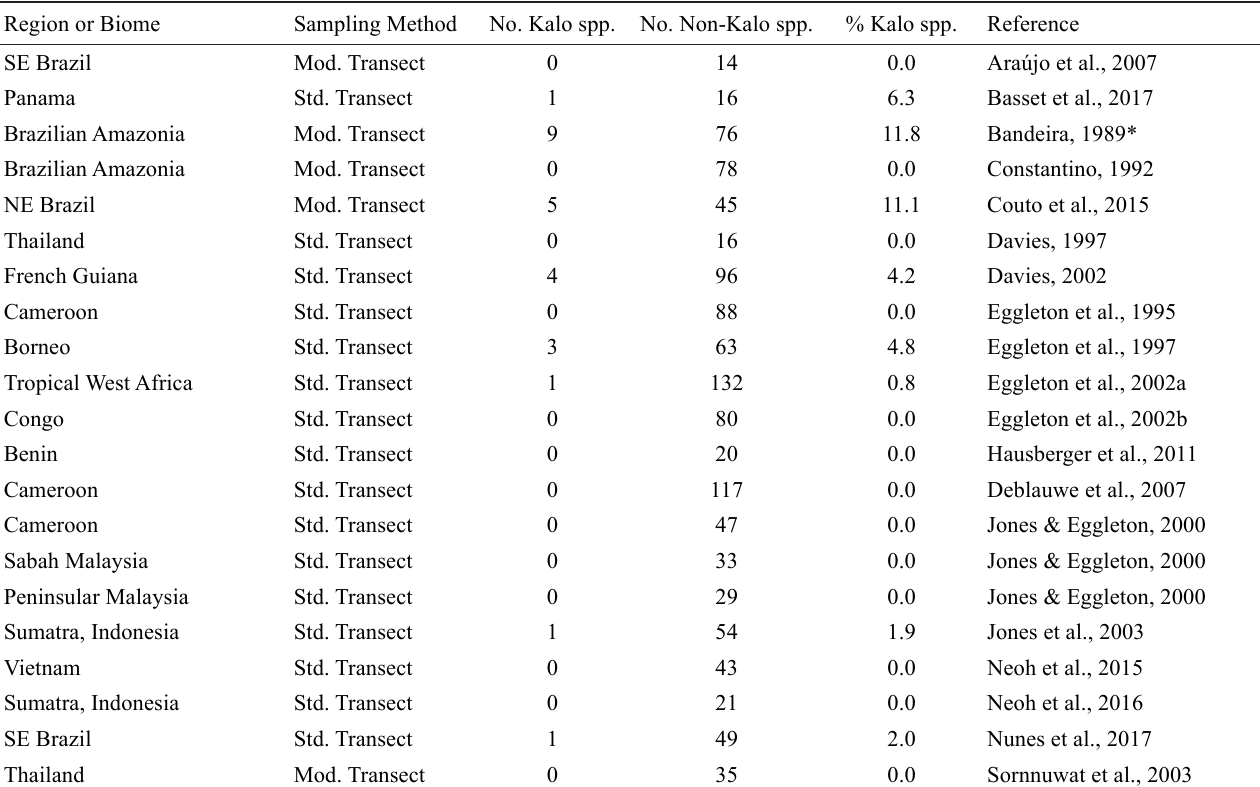
Table 2 . Studies in which occurrences of kalotermitid and non-kalotermitid termites was not enumerated. Wood was sampled in each